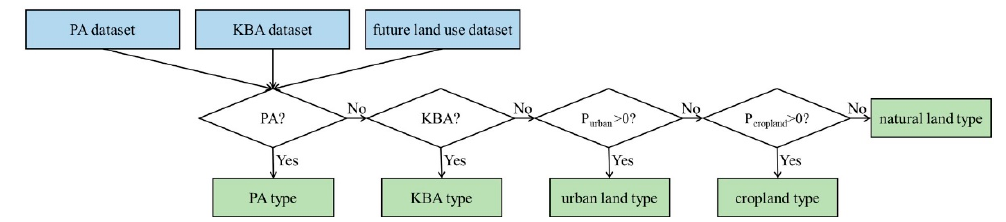
Figure 2. Flow chart of defining pixel types. Blue represents input datasets. Green represents outputs in this step, that is, pixel types we define. Here, P urban represents area percentage of urban land class in a pixel while P cropland represents area percentage of cropland class in a pixel.